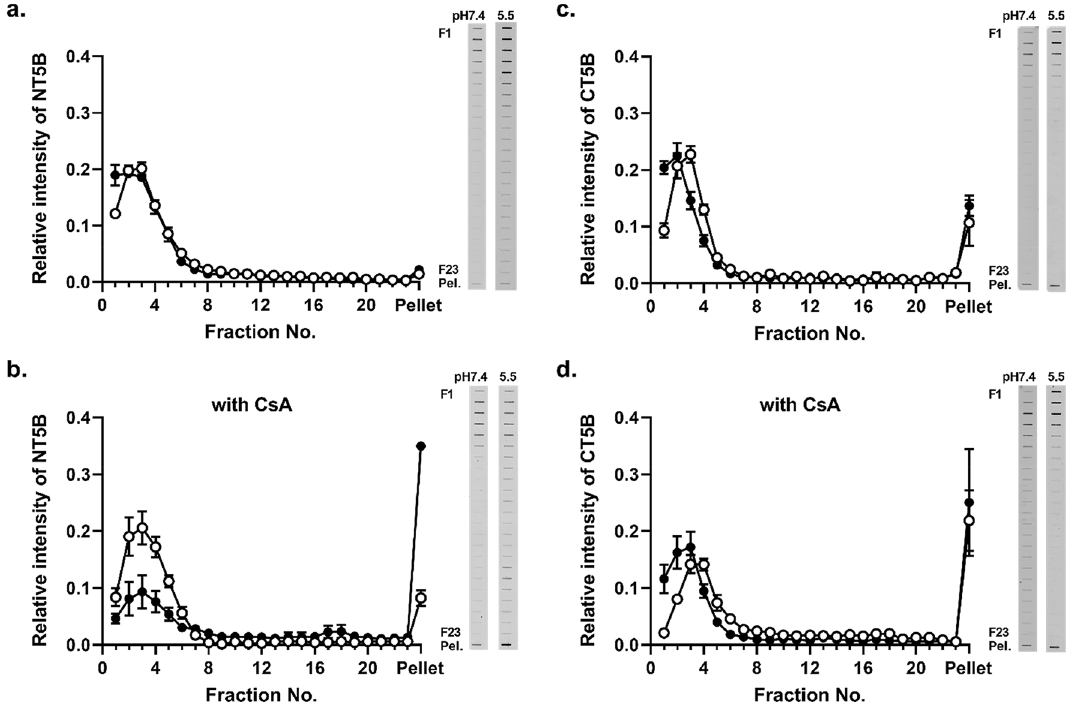
Figure 5. The effect of pH on the aggregation of MUC5B sub-domains in the presence of CsA. Rate-zonal centrifugation on 5–20% (w/v) sucrose gradients of NT5B ( a , b ) and CT5B ( c , d ) recombinant protein at pH 7.4 (white) and pH 5.5 (black) in PBS ( a , c ) or in PBS containing 200 μM CsA ( b , d ). Proteins were immunodetected in the gradient fractions using an anti-6X His-tag antibody. The results are presented as the mean ± s.e.m. (n = 3–5) from 3 independent experiments. The blots were cropped and full-length blots are presented in Supplementary Fig.